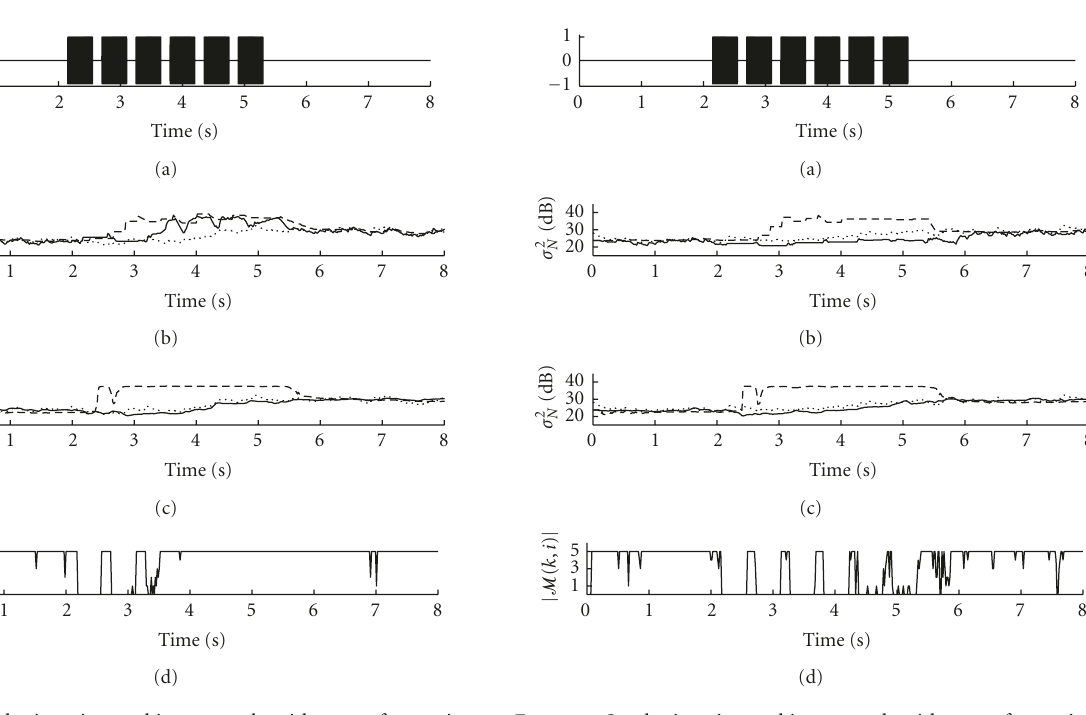
Figure 4: Synthetic noise tracking example with super-frame size of 40milliseconds. (a) Clean synthetic signal. (b) Comparison between true noise PSD (dotted line), proposed approach (solid line), and MS (dashed line) for DFT bin centered around 937.5 Hz. (c) Comparison between true noise PSD (dotted line), DFT- subspace approach (solid line), and QB approach (dashed line) for DFT bin centered around 937.5 Hz. (d) Cardinality of the set M ( k , i ) for the frequency bin centered around 937.5 Hz.